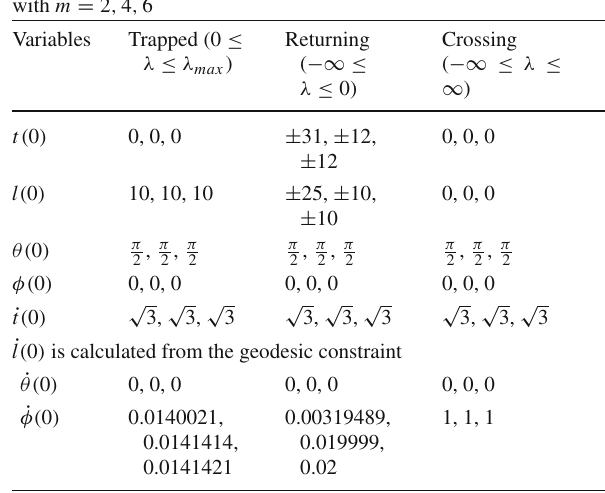
Table 1 Boundary values used for Figs. 5, 6, 7 Boundary conditions used for geodesics in 4D-GEB spacetime with m = 2 , 4 , 6